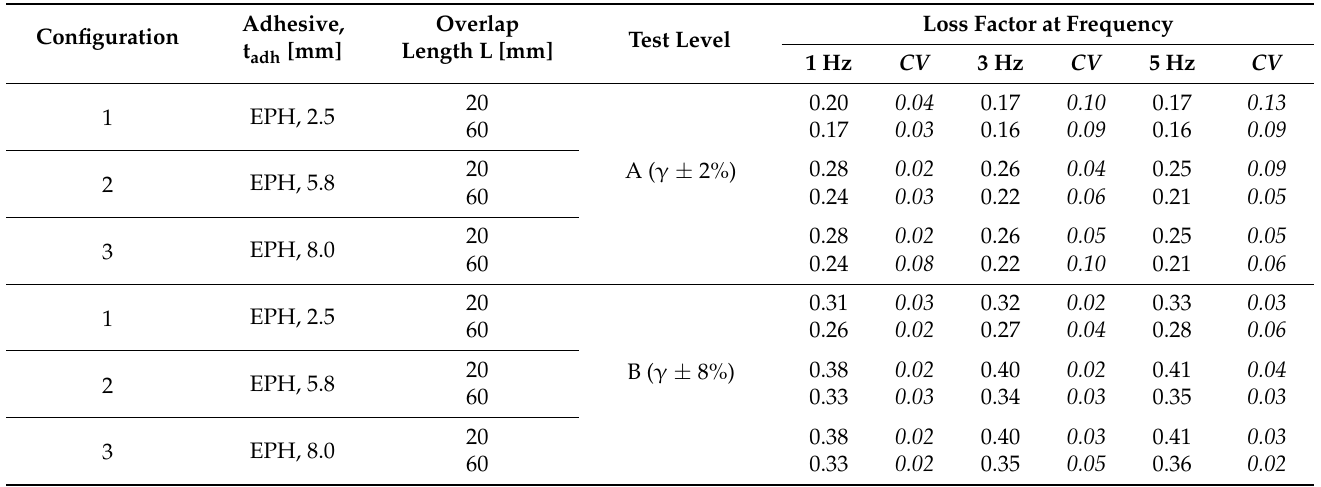
Table 2. Summary of the loss factors determined for the overlap joint configurations 1, 2 and 3 depending on the overlap length, the test level and the frequency.